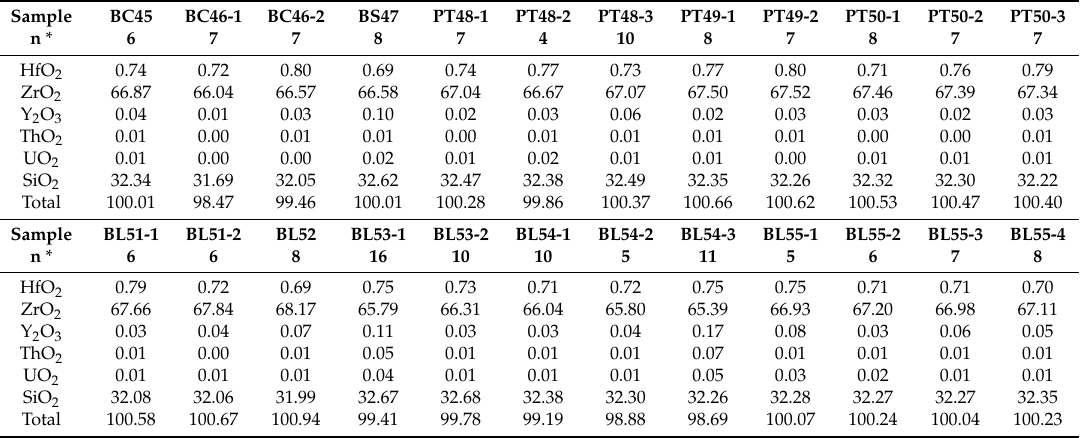
Table 1. Average EMPA analyses for RVP zircon xenocrysts.